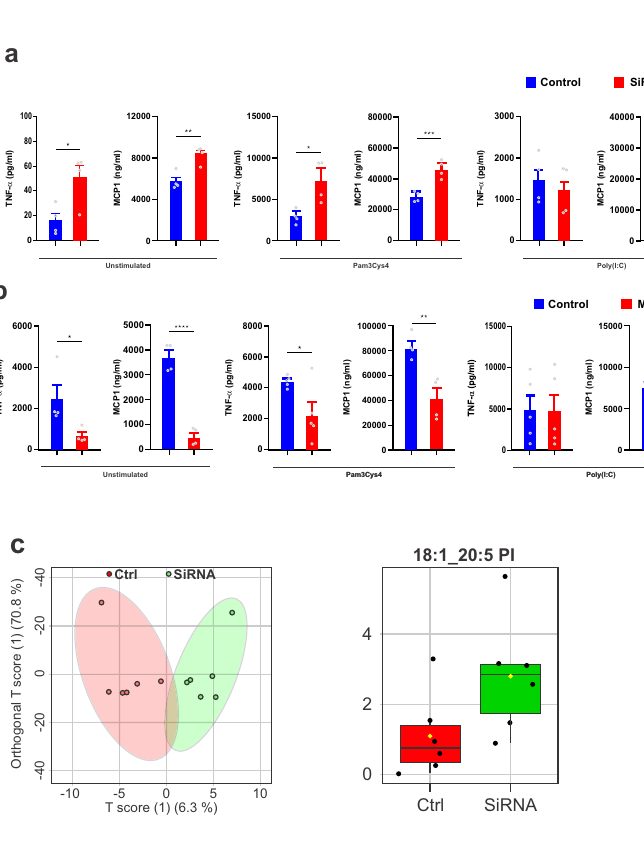
Fig.2|MBOAT7isrequiredforoptimalsecretionofcytokinesandremodelling of phospholipids in MDMs. Quantitative ELISA of the conditional media measur- ing TNF- α and MCP-1in Unstimulated MDMs and cells treated with the indicated TLRs ligands (Pam3Cys4 [TLR2], Poly(I:C) [TLR3], LPS [TLR4] and CpG [TLR9]) for 24h in a MDMs ( n =4 – 5) were transfected with MBOAT7 siRNA or scramble as control, b MDMs ( n =4 – 6) weretransfected with MBOAT7overexpressionplasmid or the empty vector as control. P -value <0.02 for all comparisons except for TLR3.